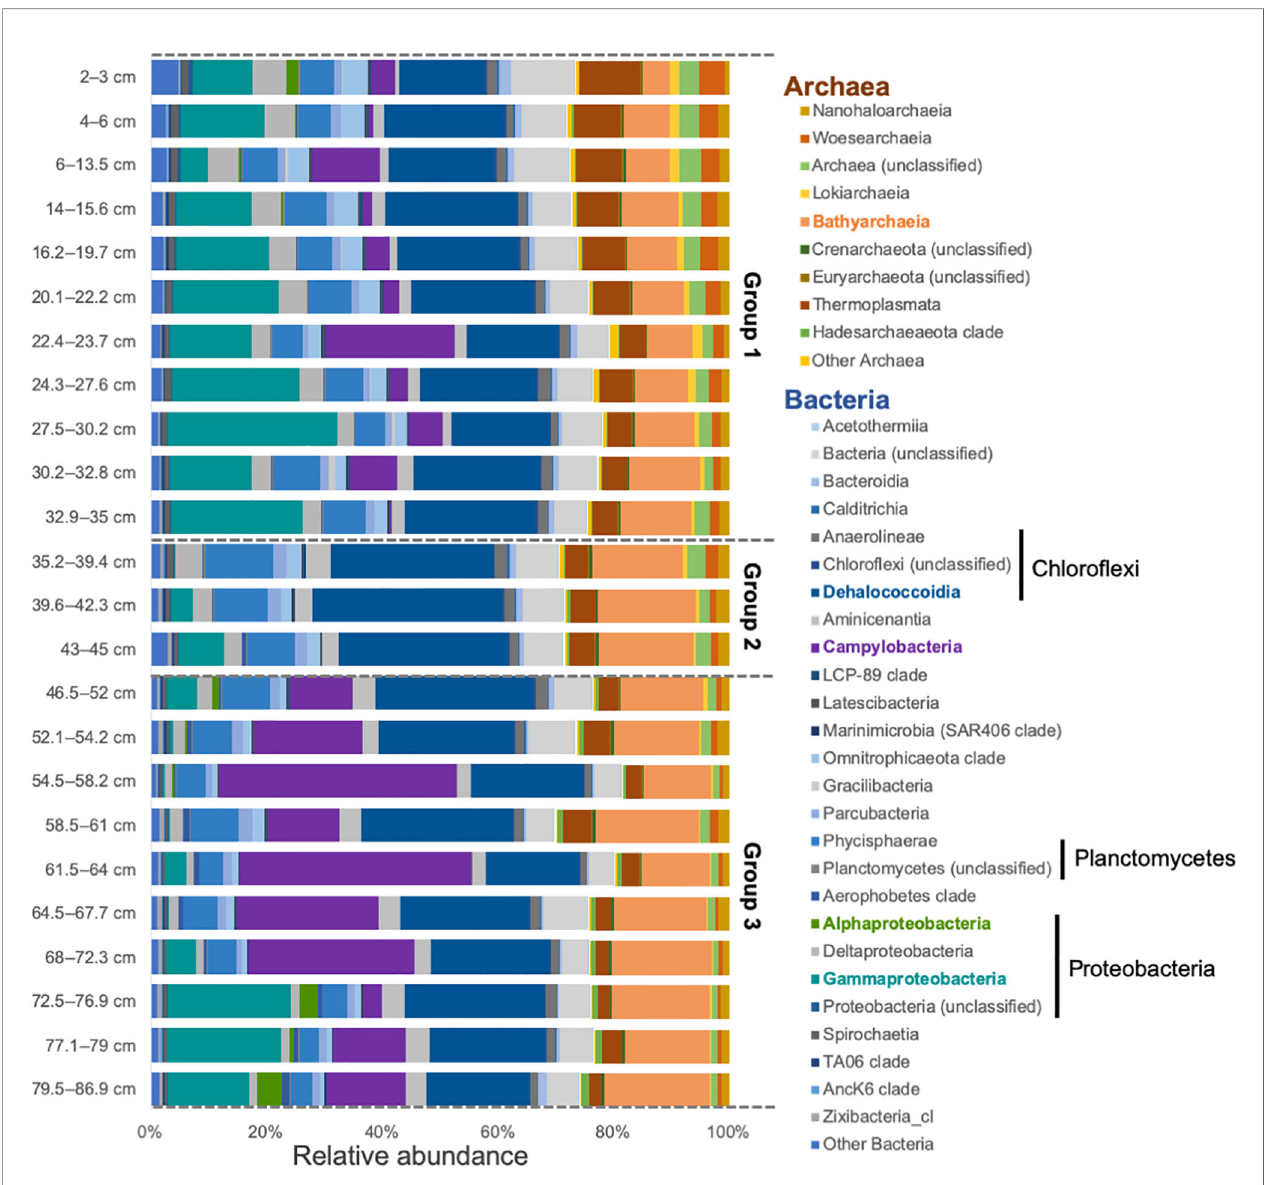
FIGURE 3 | Class level prokaryotic relative abundance for each layer of the sediment core. Groups 1, 2, and 3 are divided by the dashed lines. Taxa highlighted in color are the ones considered in the